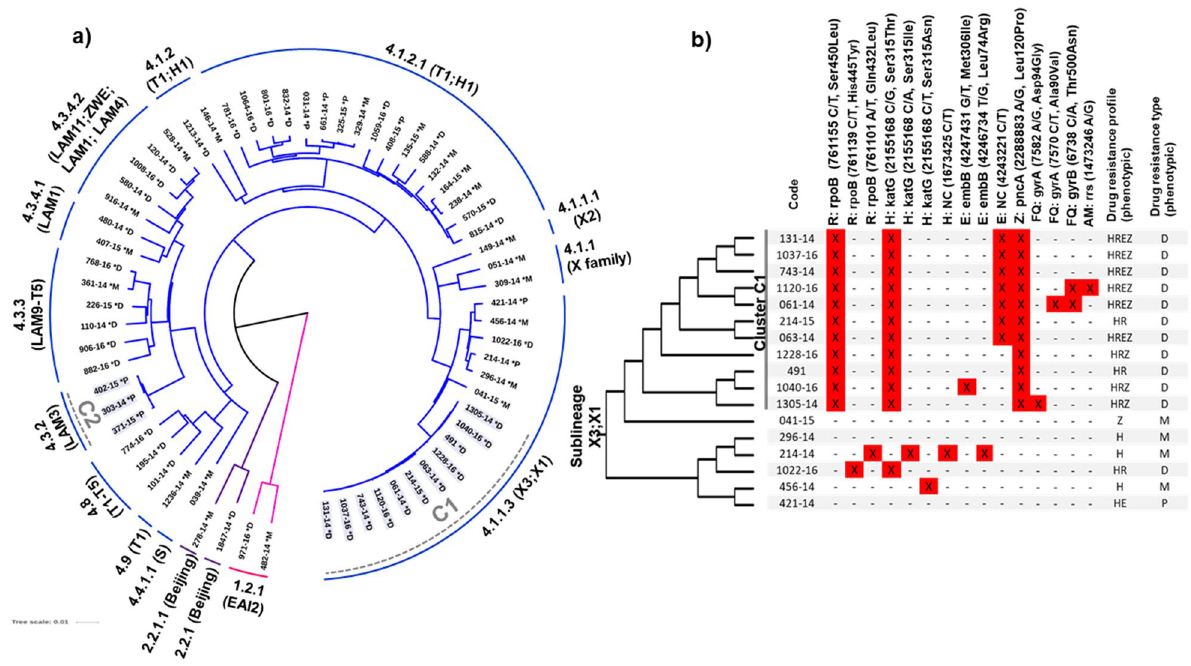
Figure 1. ( a ) Phylogenetic tree, using the maximum likelihood method, of isolates of drug resistant TB. ( b ) Comparison of mutations that confer resistance to drugs in isolates from sublineage 4.1.1.3 (X3). M mono-resistance, P poly drug resistance, D multidrug resistance, H isoniazid, R rifampicin, E ethambutol, Z pyrazinamide, FQ fluoroquinolones, AM aminoglycoside. ( a ) Tree was made using the freely version of iTOL V.4 (https